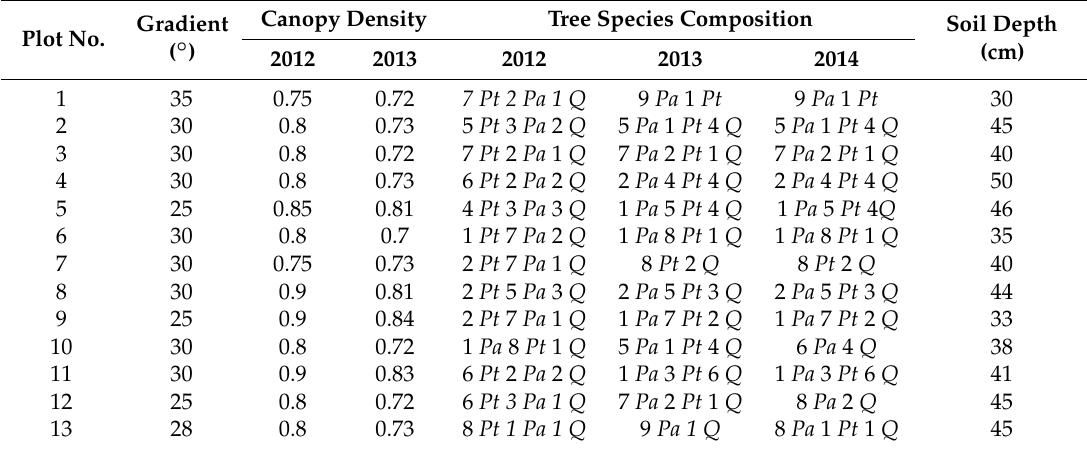
Table 1. General information of plots. Composition of tree species was calculated by their basal area. Canopy Density Tree Species Composition Soil Gradient Plot No. ( ◦ )